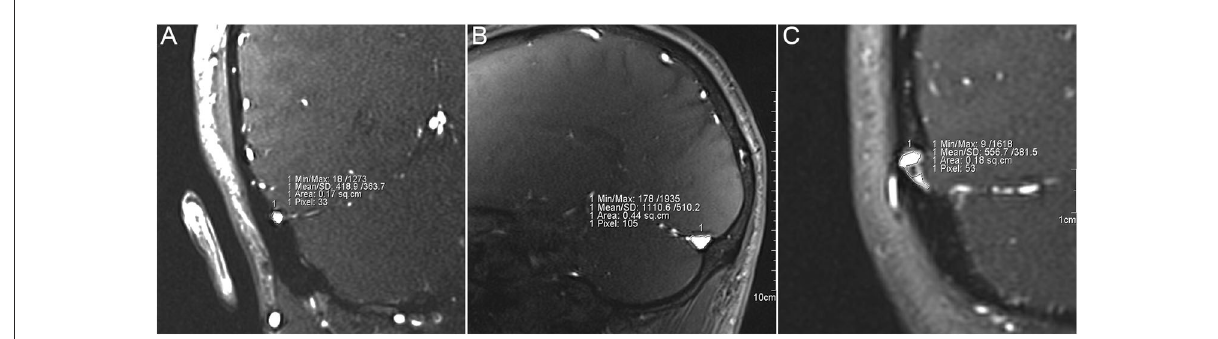
FIGURE1 Measurement of the cross-sectional area of transverse sinus (TS) stenosis. (A) Measurement of the cross-sectional area from distal (transverse-sigmoid sinus junction) to middle TS lumen using coronal magnetic resonance (MR) images. (B) Measurement of the cross-sectional area of proximal (confluence of the sinus) to middle TS lumen using coronal MR images. (C) Measurement of cross-sectional area of TS lumen with endovascular invagination of arachnoid